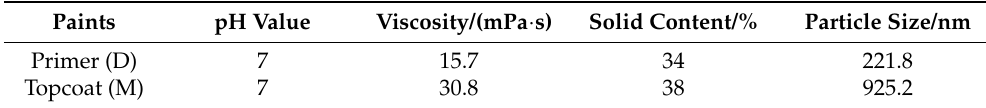
Table 1. Main performance parameters of waterborne acrylic paints.